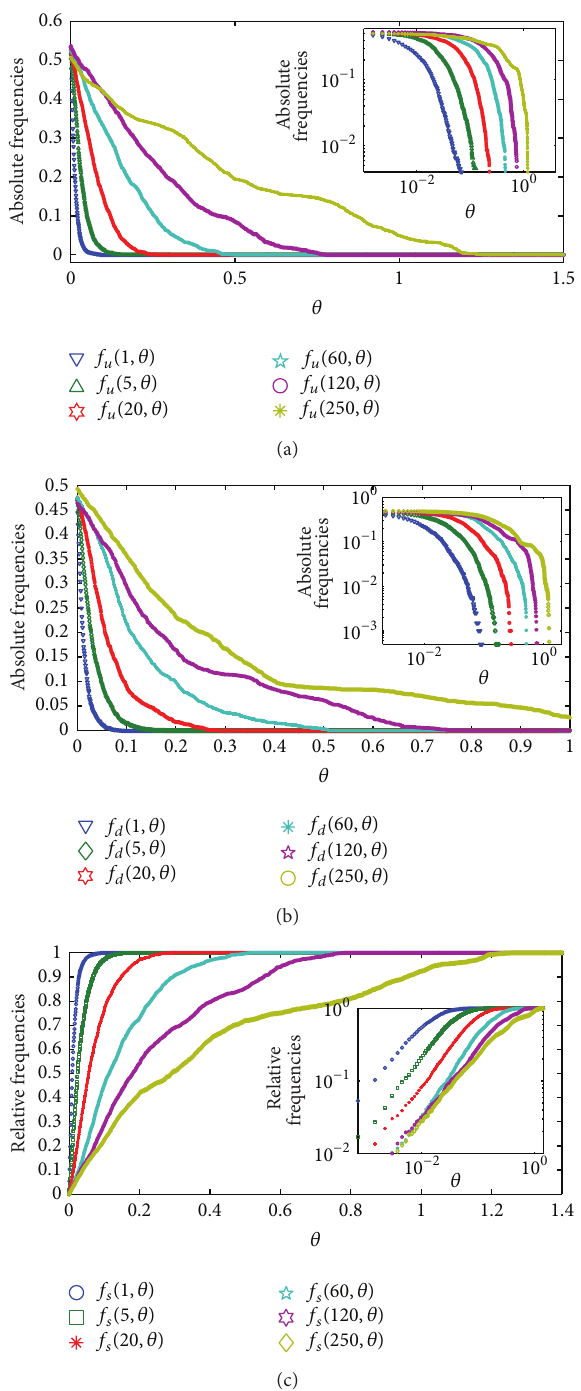
Figure 1: The evolution trends of absolute frequencies of the actual data for SSECI with the random variable 𝜃 . Plots (a), (b), and (c) are the absolute frequencies of price-up, price-down, and price-stable, respectively. The insets are the corresponding double logarithmic